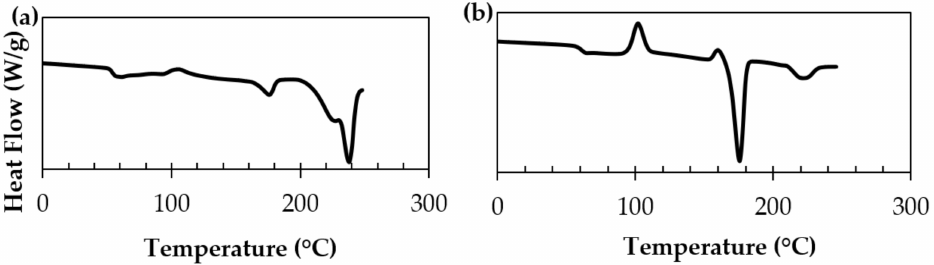
Figure 4. The DSC thermograms on stereocomplex PLA ( a ) First heating scan—stereocomplex crystallite formation ( b ) Second heating scan—thermal dissociation of stereocomplex crystallites to